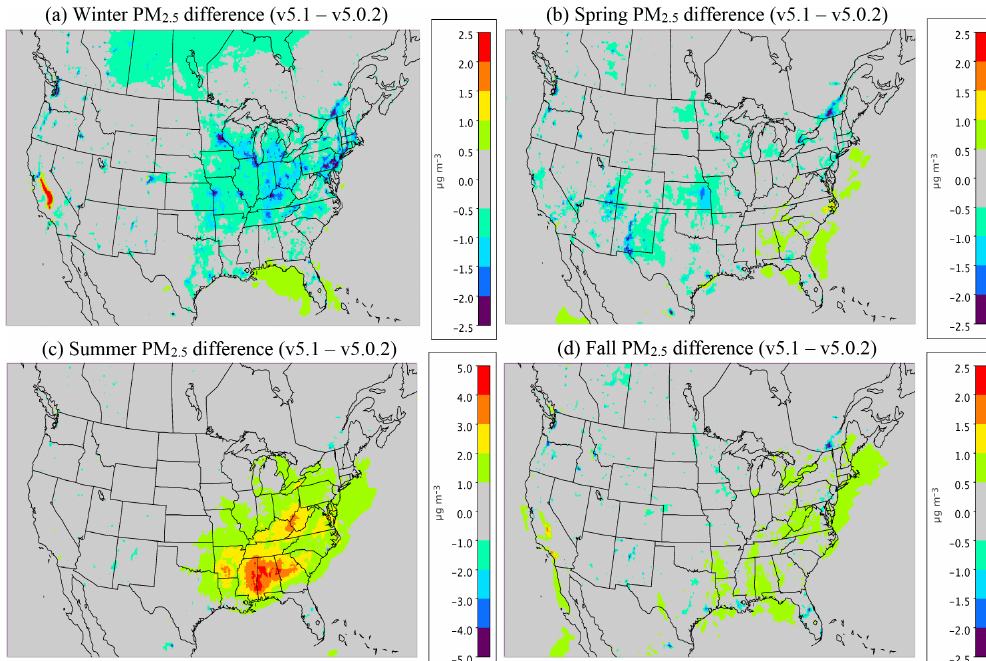
Figure 6. Difference in the seasonal average PM 2 . 5 for (a) winter (DJF), (b) spring (MAM), (c) summer (JJA) and (d) fall (SON) between CMAQv5.0.2_Base and CMAQv5.1_Base_NEIv1 (CMAQv5.1_Base_NEIv1–CMAQv5.0.2_Base). All plots are in units of micrograms per cubic meter (µgm − 3